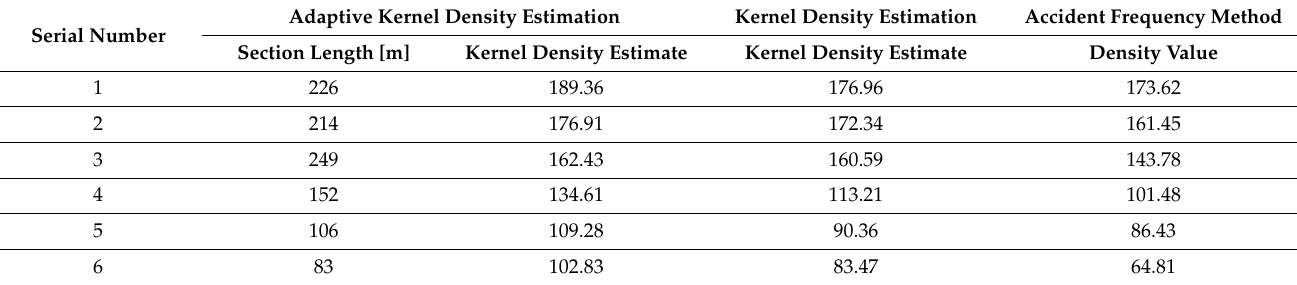
Table 4. Comparison of Results of Different Traffic Accident Black Spot Identification Methods.